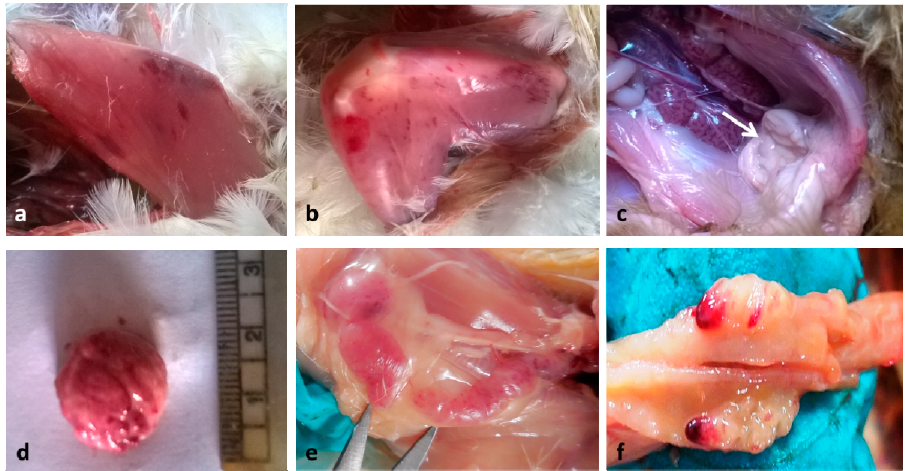
Figure 1. Gross pathological lesions caused by the vvIBD virus in different groups of chicken. ( a ) Paintbrush pattern hemorrhages in the breast and ( b ) thigh muscles of NWG at 4 dpi. ( c ) Edematous enlarged bursa (arrow) and enlarged pale kidneys with tubules distended with urates in NAG at 4 dpi. ( d ) Enlarged and hemorrhagic bursa in NWG on 5 dpi. ( e ) Petechial hemorrhages in the thymus of NWG at 5 dpi. ( f ) Hemorrhages in caecal tonsils of NAG at 3 dpi. NWG- Nonvaccinated challenged White Leghorn Group; NAG-Nonvaccinated challenged Aseel Group. Table 2. Depicting the semi-quantitative assessment of the severity of disease based on gross lesions in lymphoid organs among the challenged and control chicken of various groups. Group